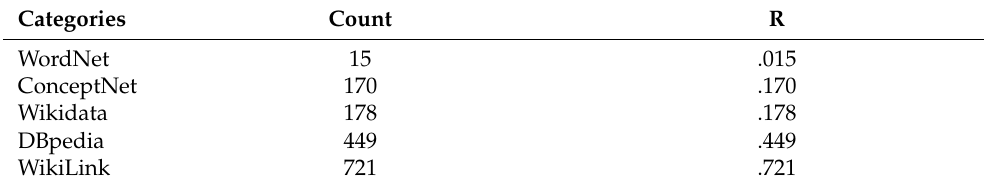
Table 3. Evaluation results of golden